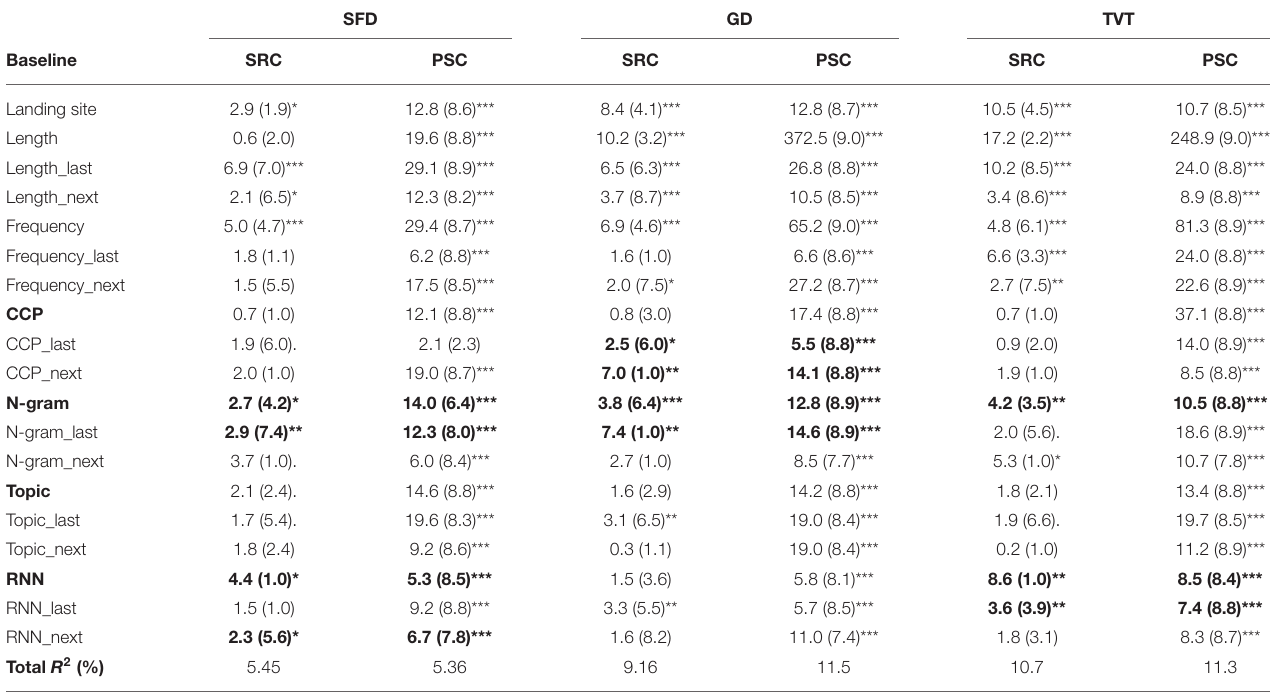
TABLE 8 | The F -values of the predictors (effective degrees of freedom), their significance level and the total amount of variance explained in models including all predictors at the same time. SFD GD TVT